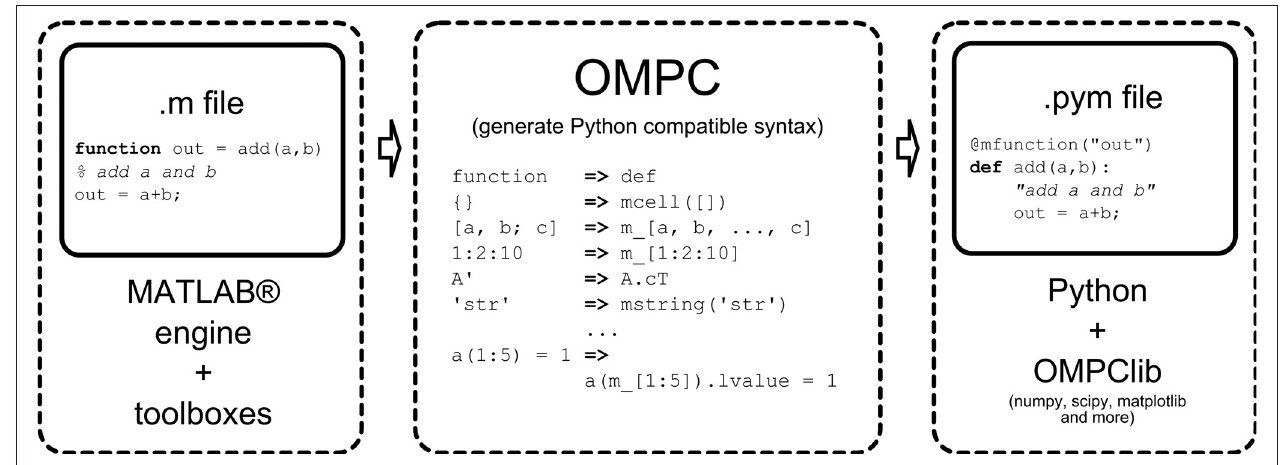
FIGURE 1 | OMPC structure. Each . m fi le has to be translated to Python compatible syntax. Statements for an . m fi le are replaced by their Python equivalents with minimal structural changes that allow emulation. This translated code relies on features implemented in a numerical object similar to ndarray of the numpy